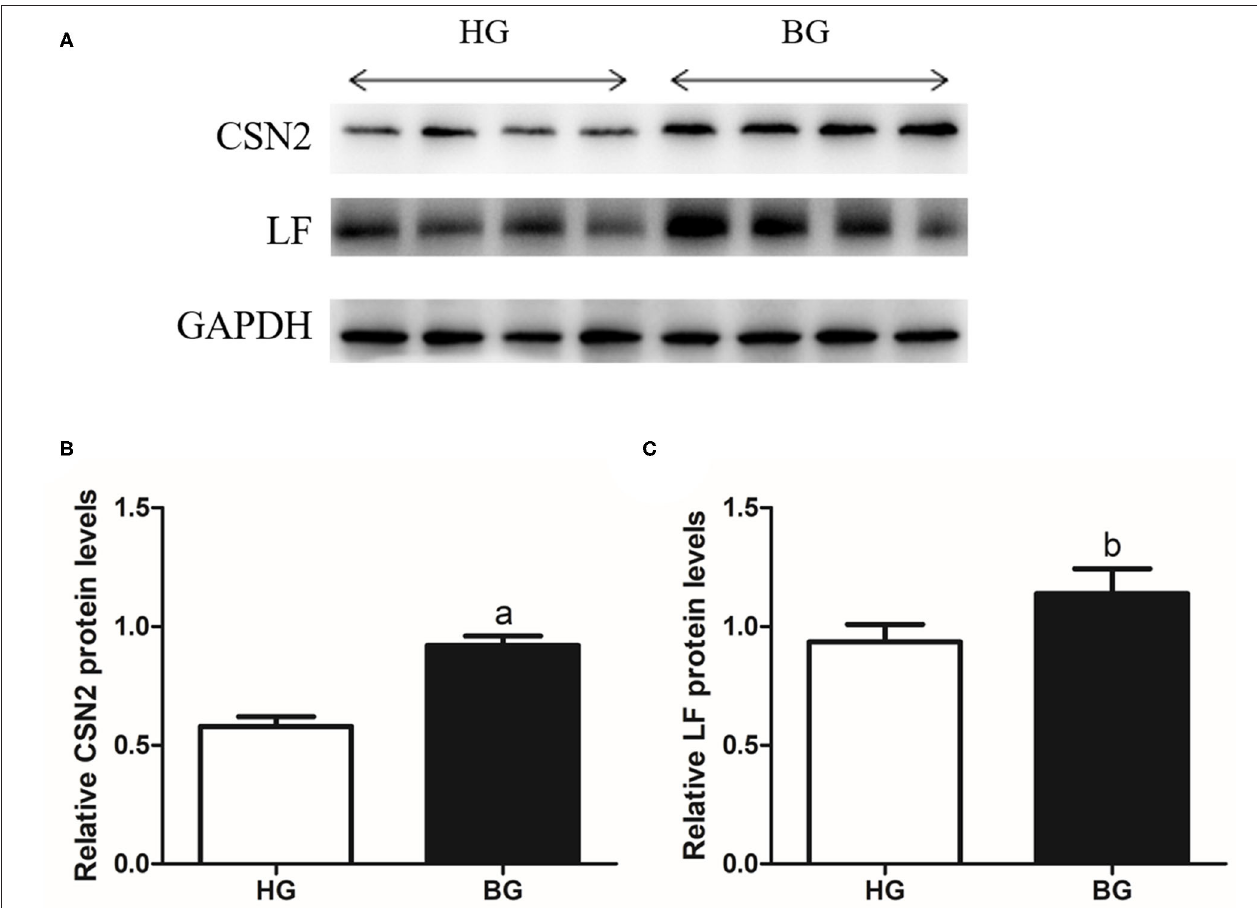
FIGURE 6 | Western blot analysis of the CSN2 and LF. (A) Indicated protein levels were measured by western blotting analysis. (B,C) Relative protein levels of CSN2 (B) and LF (C) from the western blots were quantified by gray scale scan. Values are mean ± SEM. n = 4/group. b p < 0.05 and a p < 0.01, compared with high grain